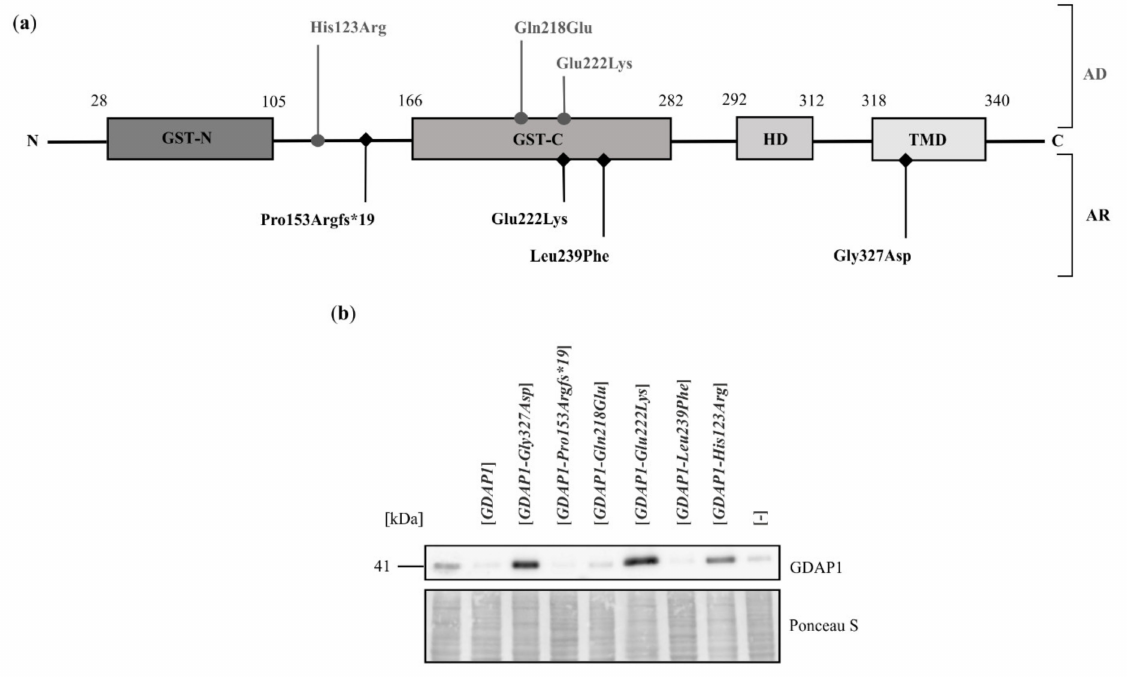
Figure 2. Expression of various GDAP1 alleles in HeLa cells affects the level of endogenous GDAP1. ( a ) Schematic representation of GDAP1 structure including amino acid residue substitutions that result from the GDAP1 variants of autosomal dominant (AD; above schematic) or autosomal recessive (AR; below schematic) modes of inheritance. ( b ) Western blot analysis using anti-GDAP1 antibody. Shown are total cell extracts from non-transfected HeLa cells (first lane from left), HeLa cells transfected with empty vector ([-]) or HeLa cells transfected with vectors carrying the indicated GDAP1 variants. The samples were normalized for protein loading using Ponceau S